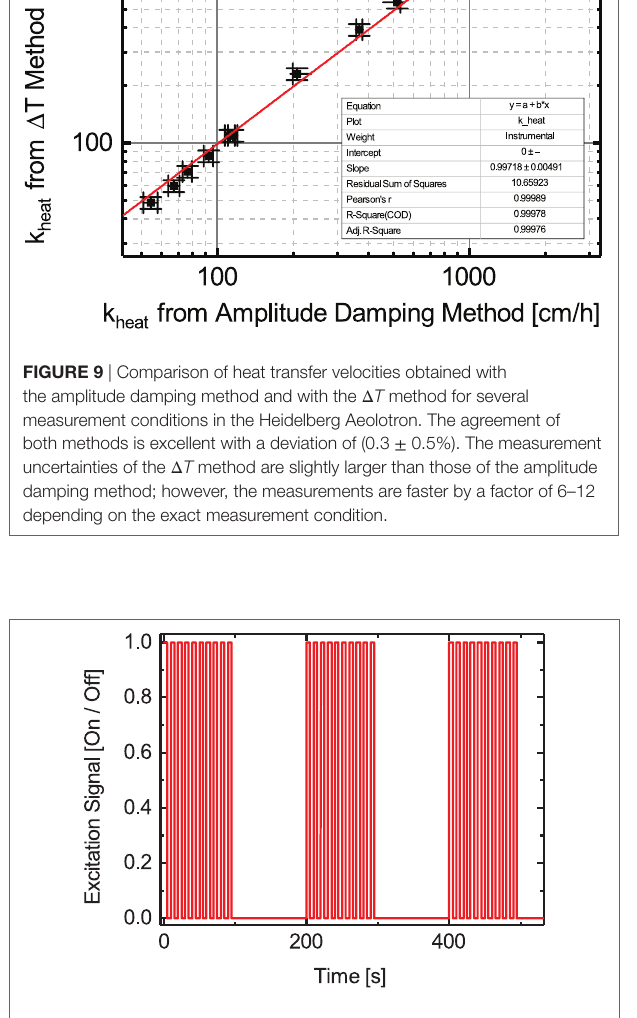
FigURe 10 | Example for a multifrequency excitation. A low frequency of 0.005 Hz and a higher frequency of 0.1 Hz are applied at the same